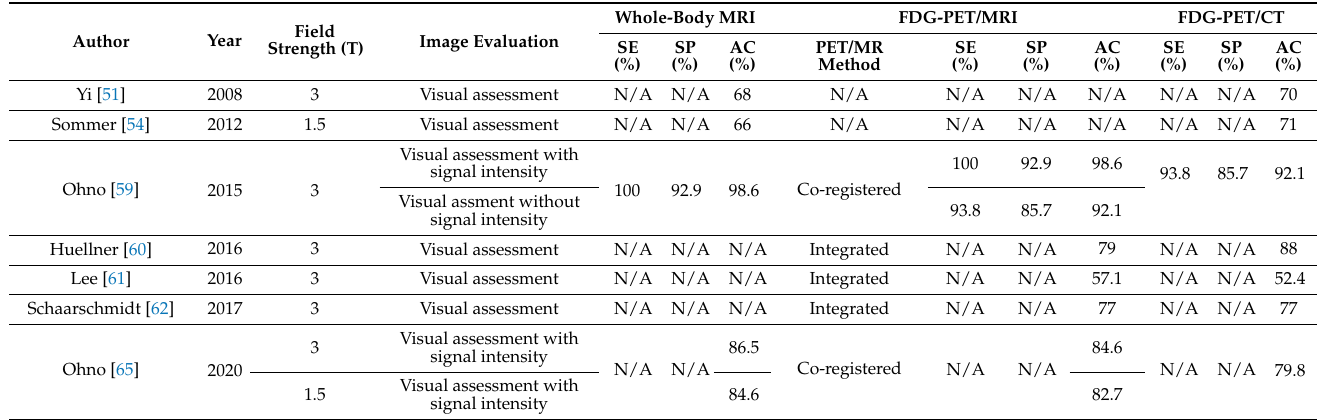
Table 6. Summary of diagnostic performance of N-factor assessment using whole-body MRI or